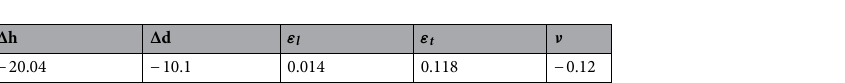
Table 7. Measured displacements, strains and Poisson’s ratio of auxetic composite in the case of compression test.